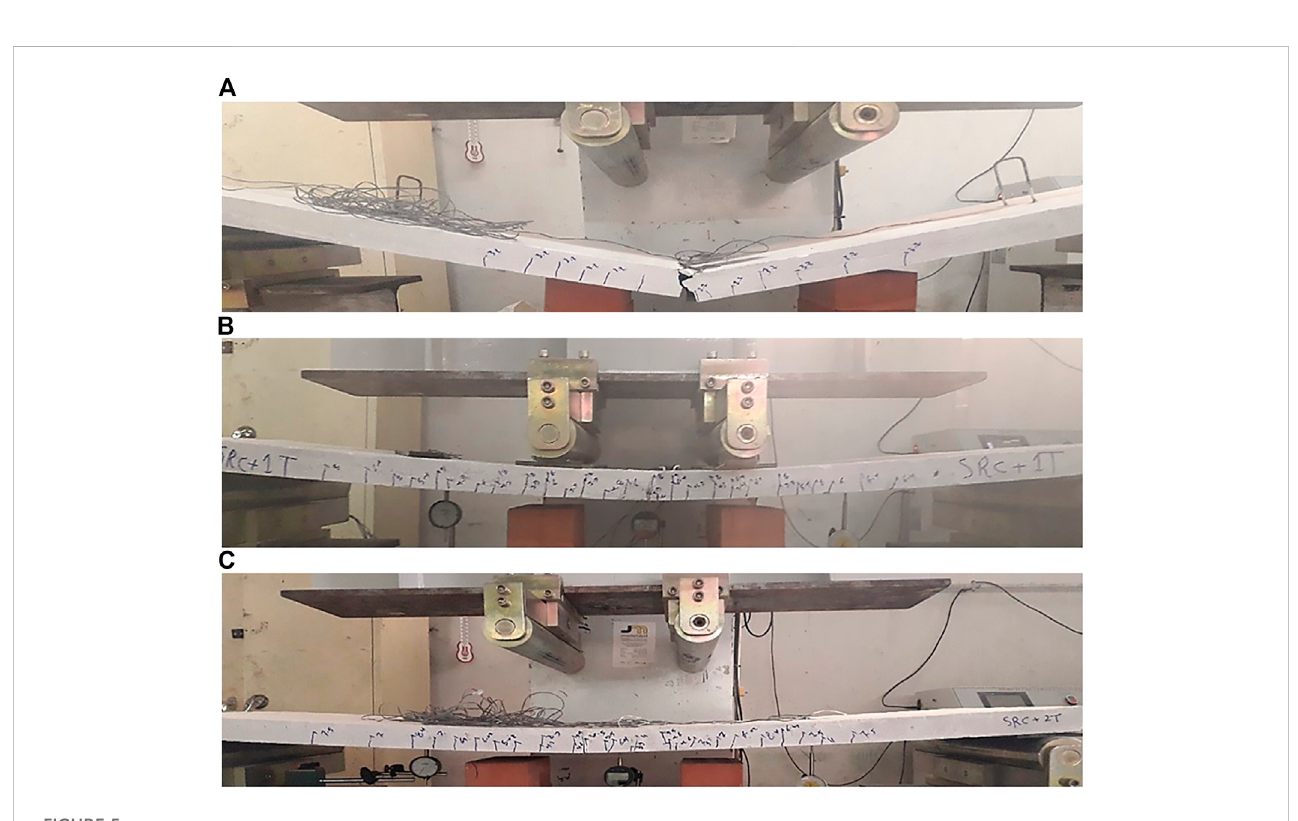
FIGURE 5 Flexural failure of slabs; (A) SRC (B) SRC + 1T (C) SRC + 2T.